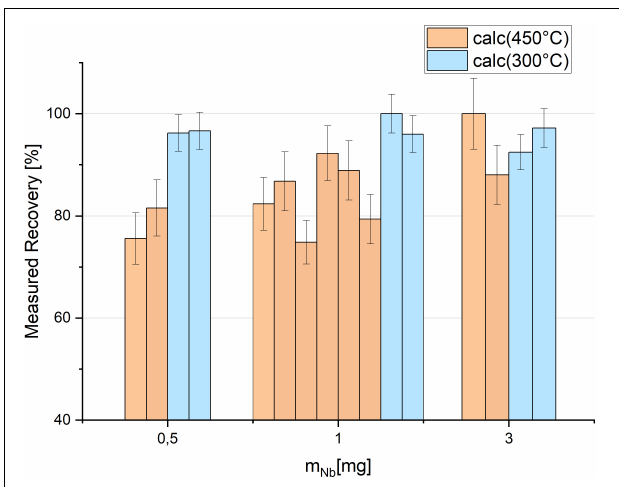
FIGURE 5 | 95m Tc recovery after calcination at 450 and 300 ◦ C in comparison measured by gamma counting. 95m Tc was embedded in different amounts of Niobium (Nb) and prepared in individual